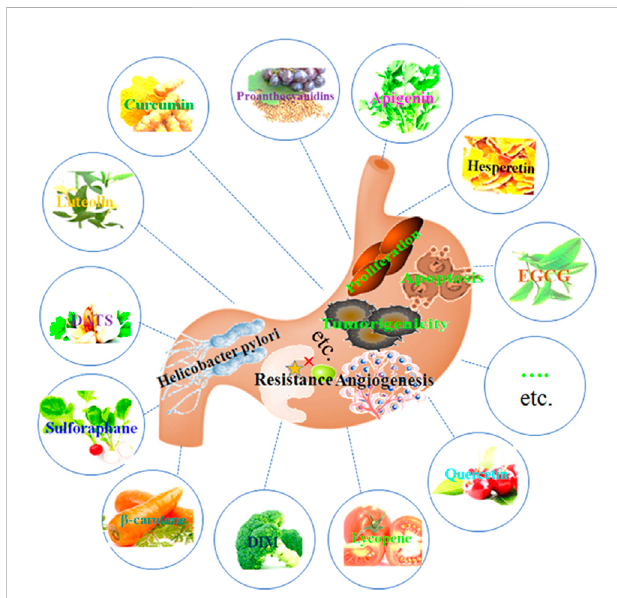
FIGURE 1 Phytochemicals have protective effects against GC through inhibiting cell proliferation, inducing cell apoptosis and autophagy, suppressing cell invasion and migration, anti-angiogenesis, inhibiting Helicobacter pylori infection, regulating microenvironment, and other possible mechanisms.